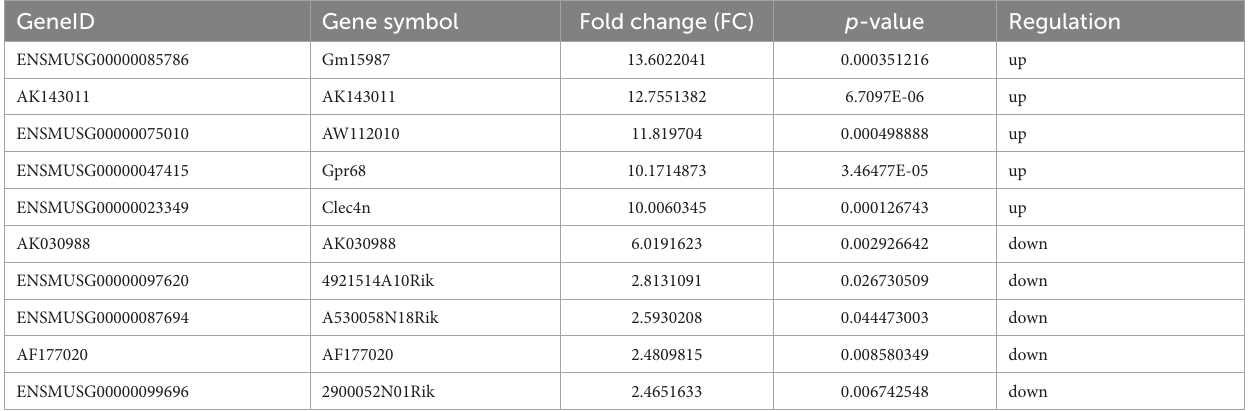
TABLE 3 Top 5 up-regulated and down-regulated lncRNAs post-ICH.